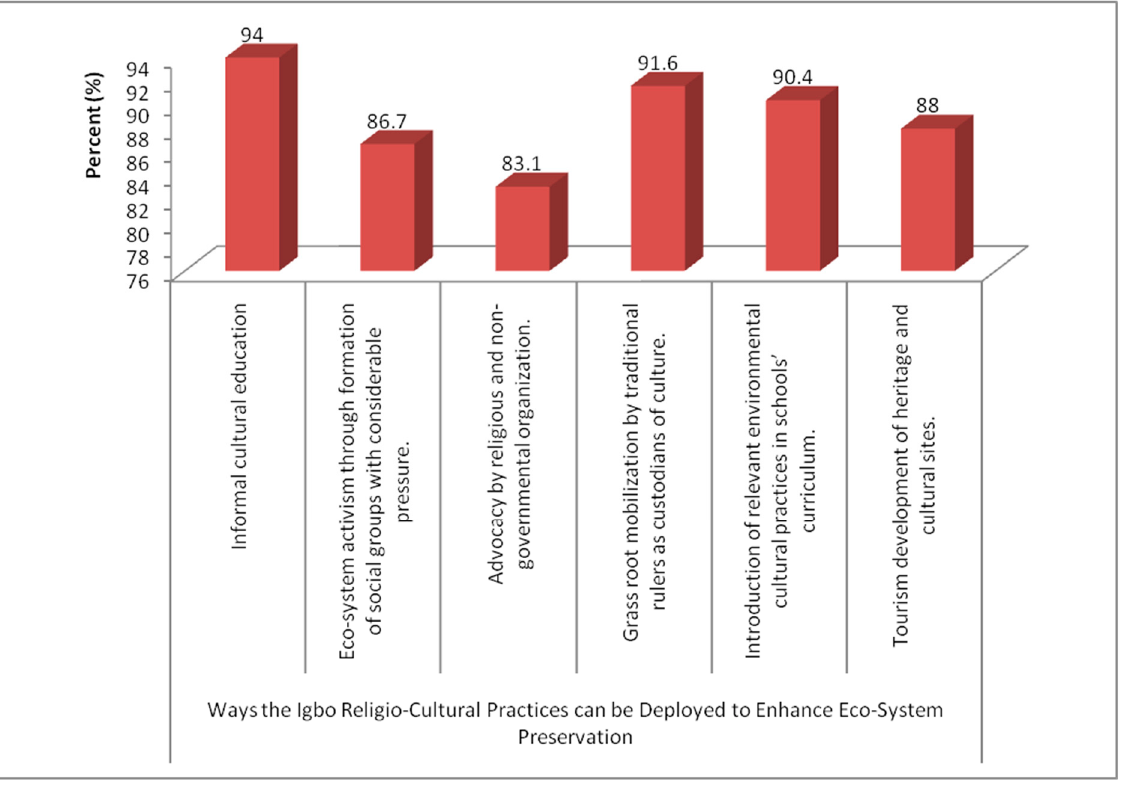
Figure 3. Ways the Igbo Religio-Cultural Practices can be Deployed to Enhance Ecosystem